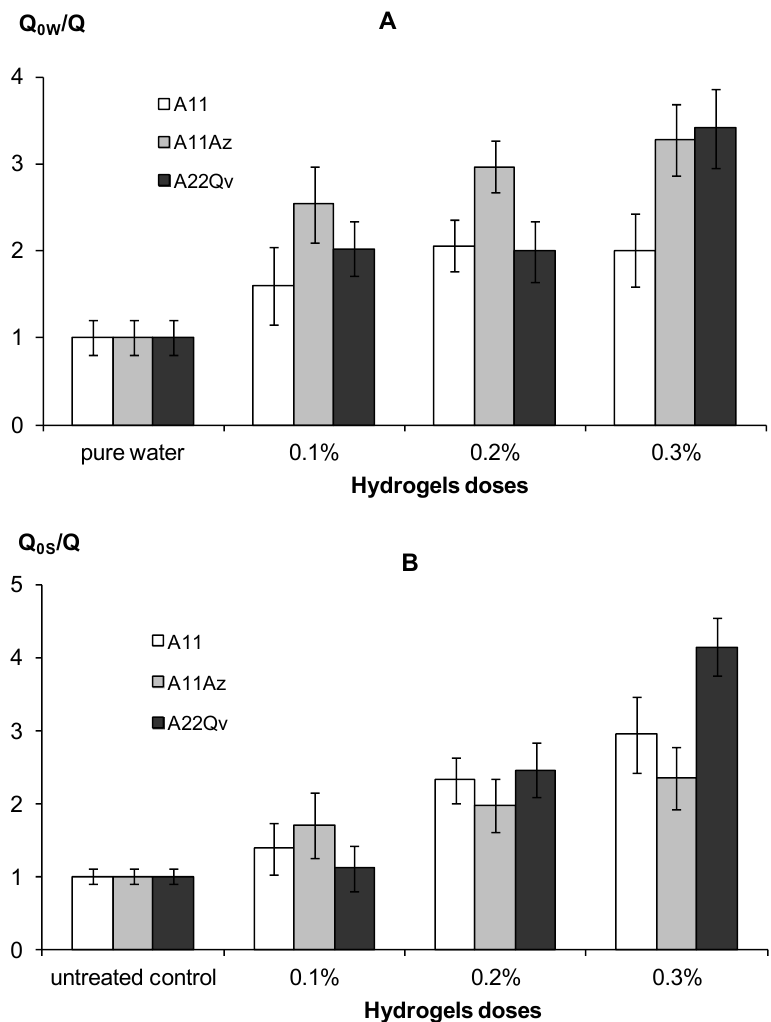
Figure 11. Indicators of a decrease in water evaporation under the influence of gel structures in comparison with pure water ( A ) and sandy substrate ( B ).